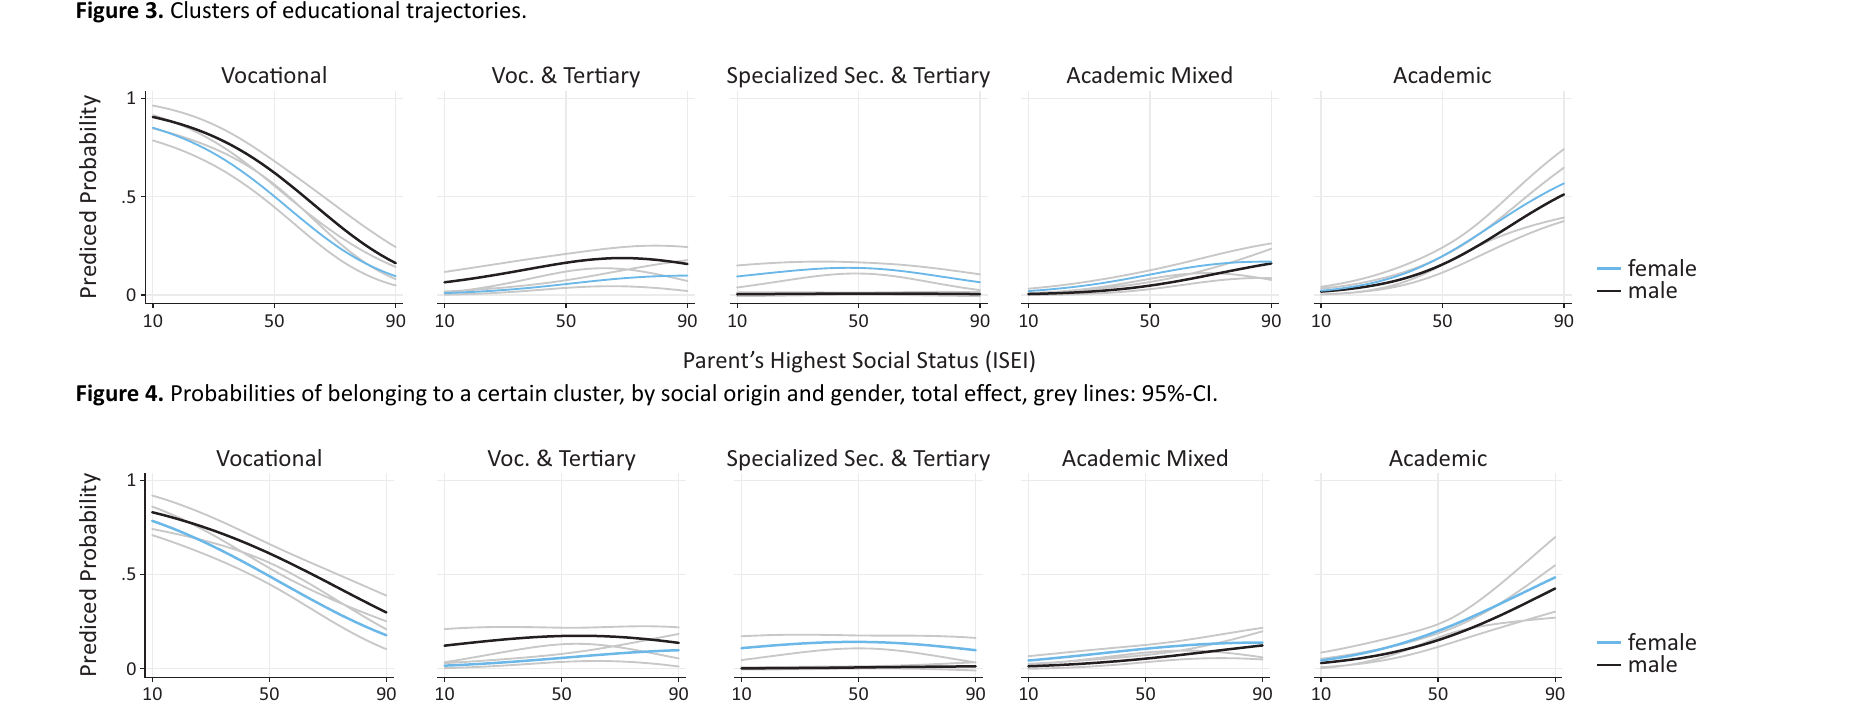
Figure 3. Clusters of educational trajectories.